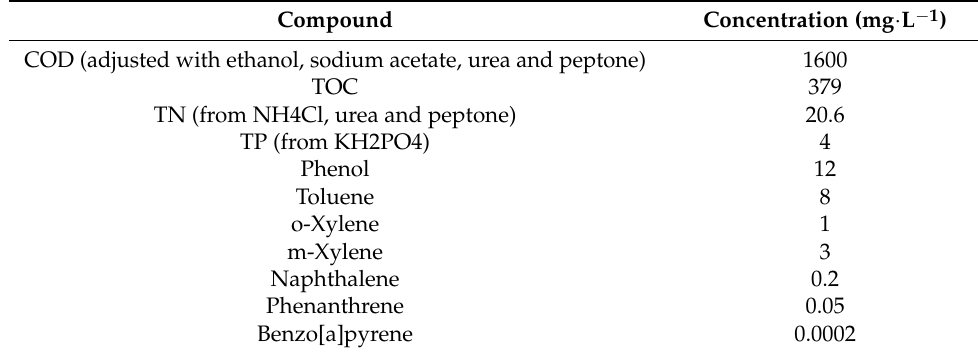
Table 1. Composition of the synthetic produced water.